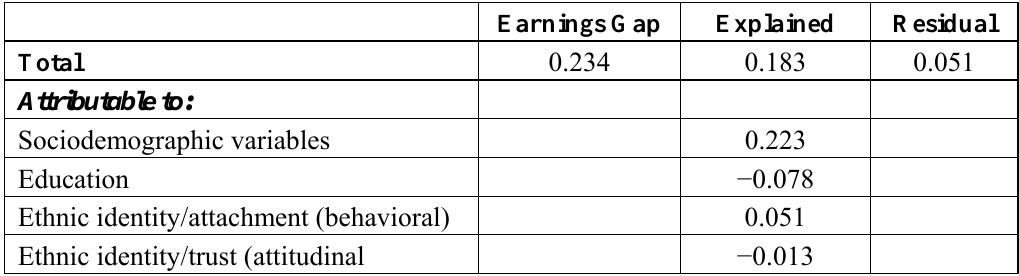
Table 3. Oaxaca [58] regression decomposition of the earnings